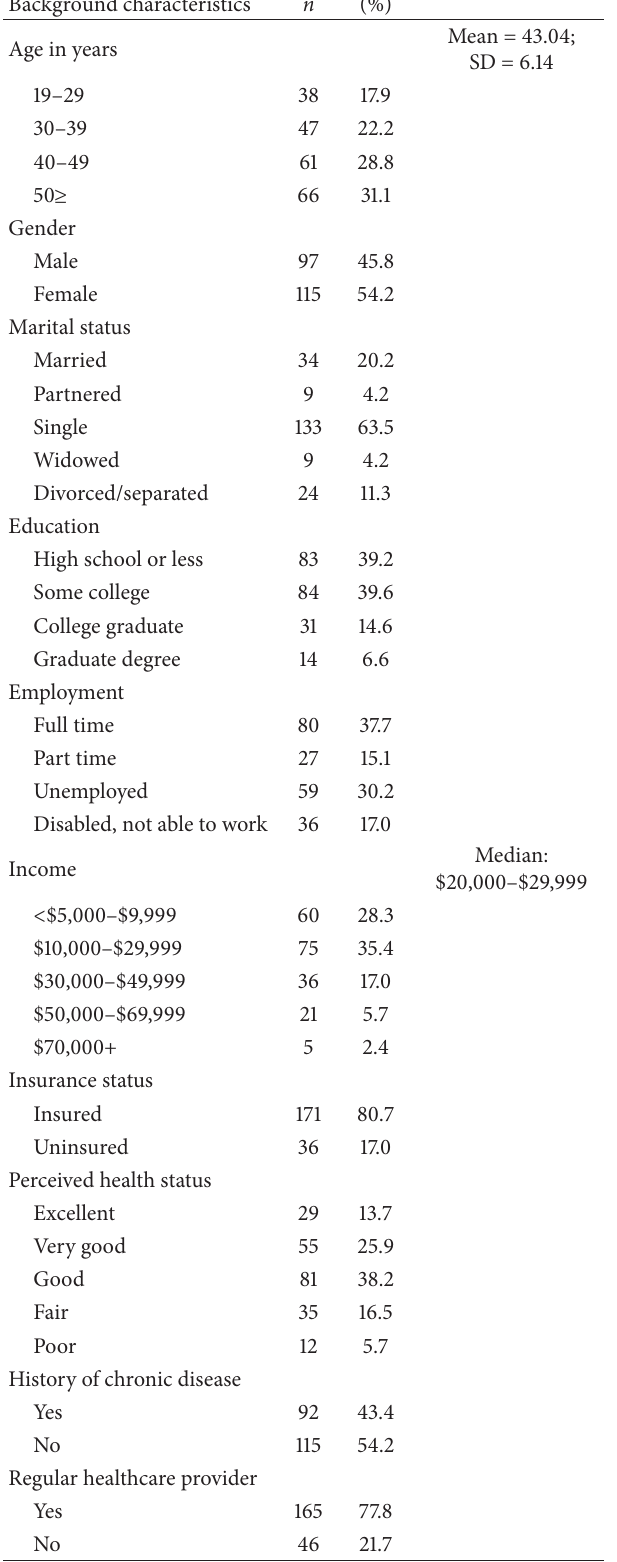
Table 1: Profile of the study participants ( 𝑁 = 212